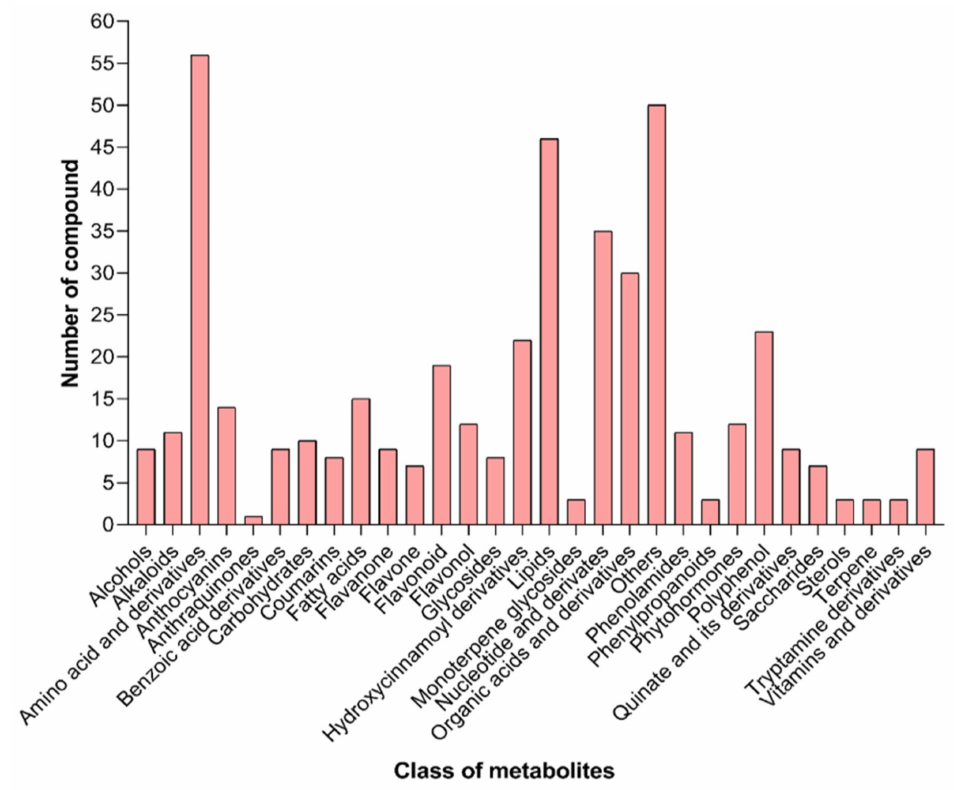
Figure 2. Metabolites detected in ripe wolfberry fruits based on metabolite compound